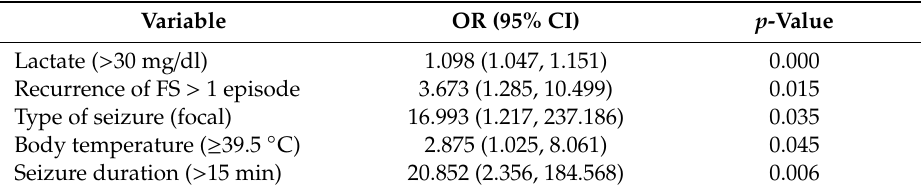
Table 2. Multiple logistic regression model to predict stress